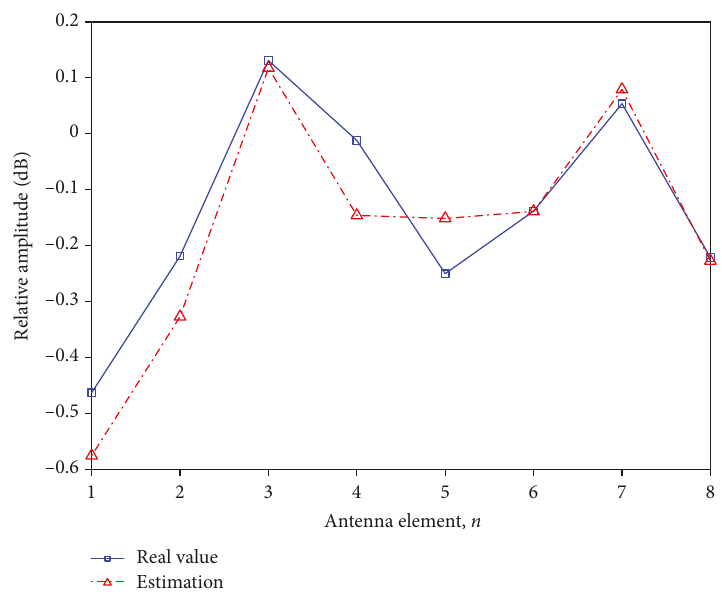
Figure 5: The array element relative amplitude and the corresponding estimation results.